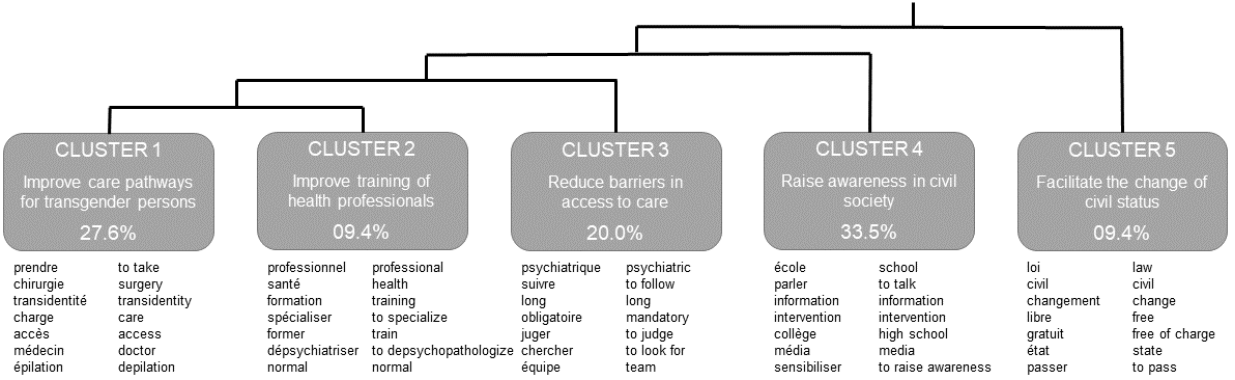
Figure 1. Descending Hierarchical Classification of 92.9% of the corpus. Correlations are based on chi-squared test cluster vs. remaining corpus. Significance level for lemmas is p < 0.05 with up to seven lemmas and their English translation illustrating each cluster. Table 2. Recommendations from participants to improve the information, support, or care provided, and response from health professionals. Cluster Representative Quotes (Gender; Set)